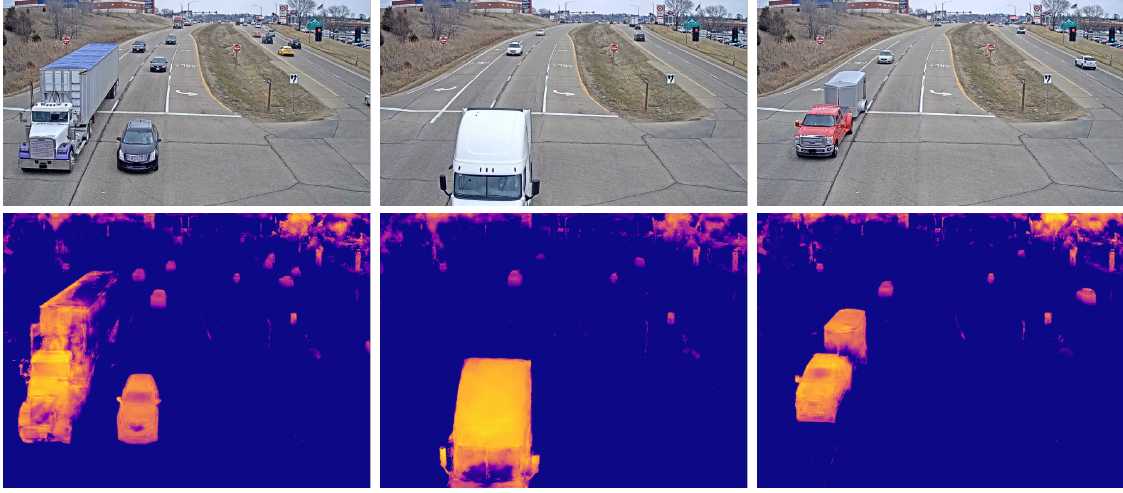
Figure 7. Failure cases of Height